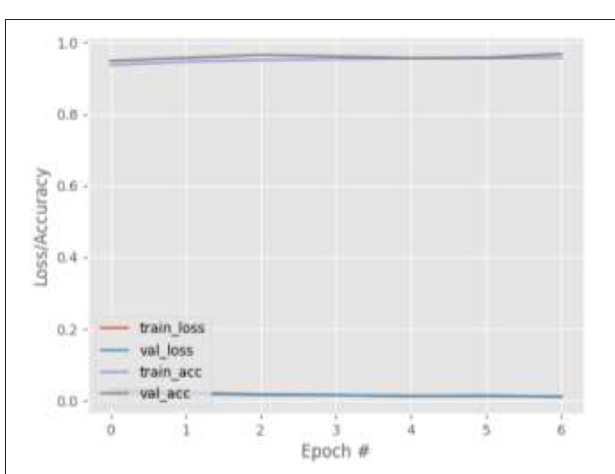
FIGURE 5 | Results for Face + FL + VGG16 on GazeCapture